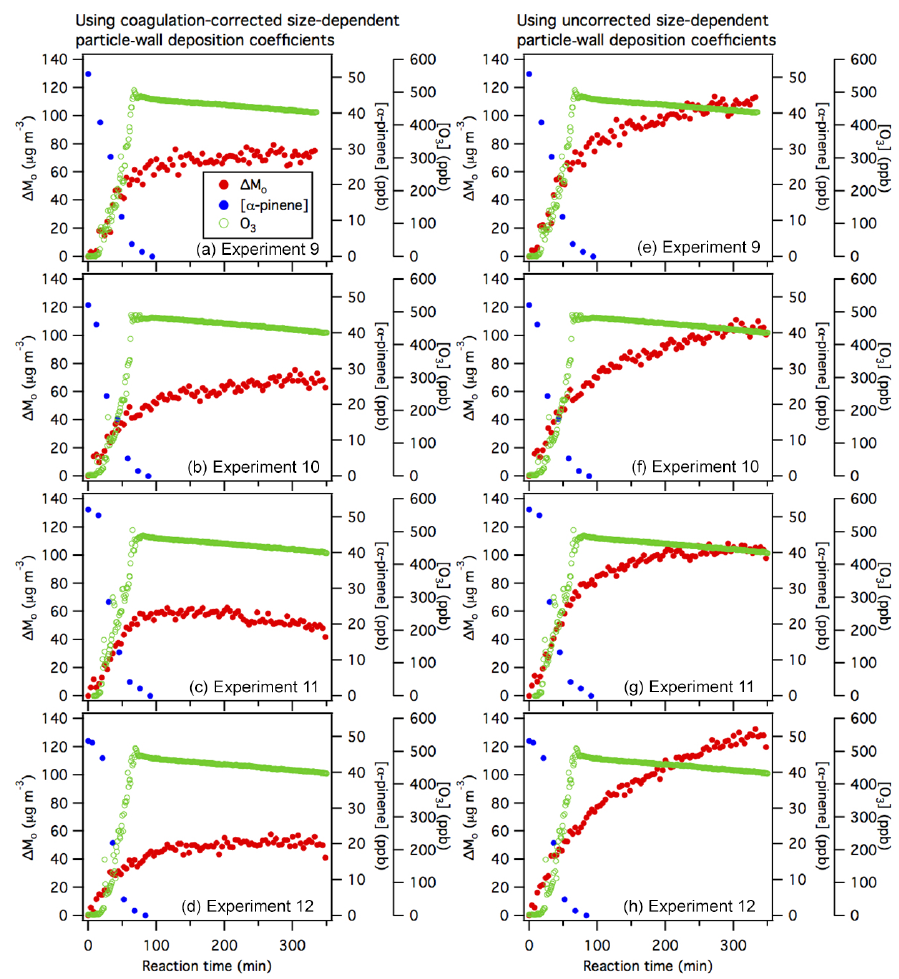
Figure 3. Reaction profiles of the high-SA α -pinene ozonolysis experiments. Panels (a–d) show SOA mass concentrations ( (cid:49)M o ) obtained using the coagulation-corrected size-dependent particle-wall deposition coefficients from the high-SA seed-only experiments, while pan- els (e–h) show SOA mass concentrations ( (cid:49)M o ) obtained using the uncorrected size-dependent particle-wall deposition coefficients from the high-SA seed-only experiments. Refer to Table 1 for information on the AS solution(s) used to generate the seed aerosol and the initial seed aerosol surface area concentrations in these experiments. As explained in the main text, SOA mass concentrations are substantially overestimated when the uncorrected size-dependent particle-wall deposition coefficients are used to account for particle-wall